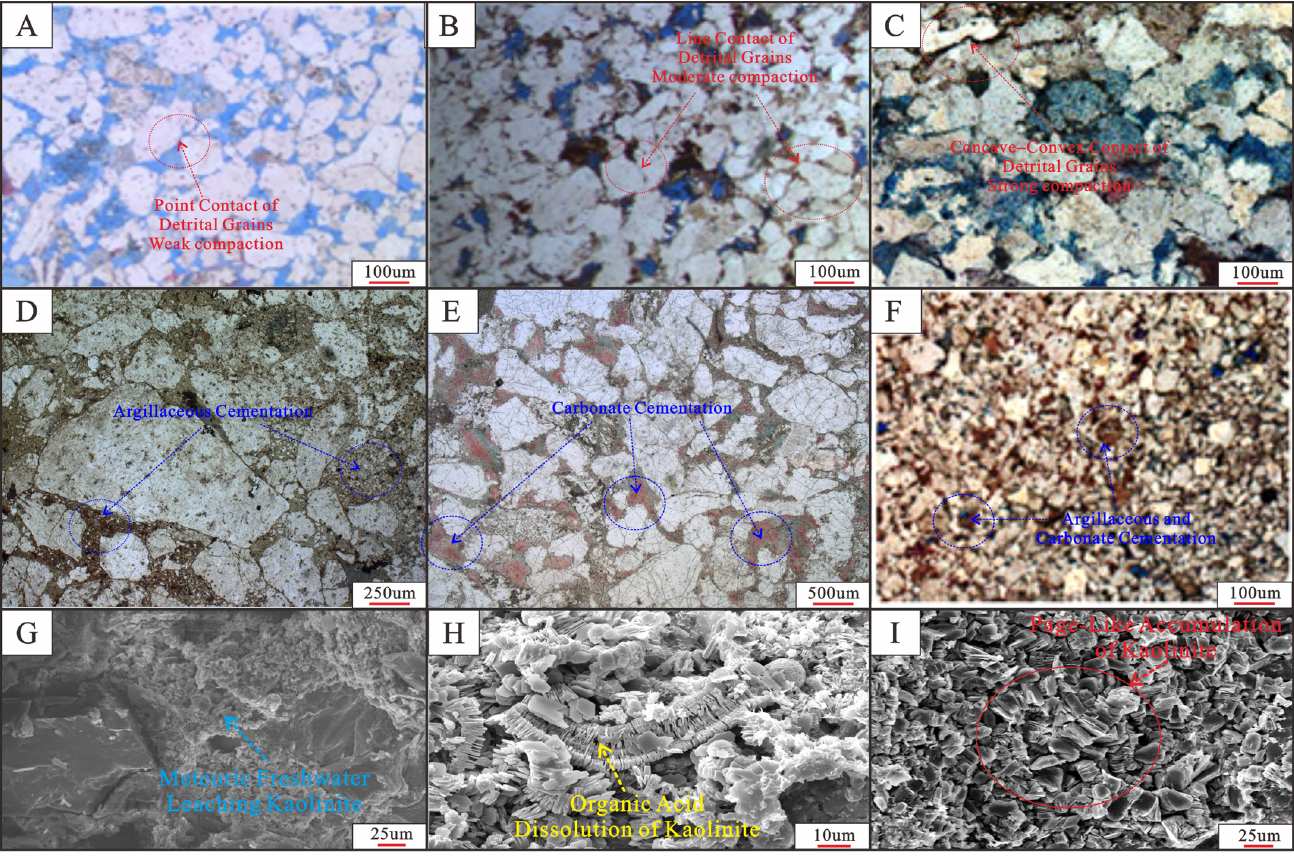
Figure 6. The thin section and scanning electron microscope photographs of the diagenesis of a typical well in the northern steep-slope zone of the Weixinan Sag. ( A ). Well W5, 2053.2 m, the point contact of detrital grains. ( B ). Well C3, 3158.44 m, the line contact of detrital grains. ( C ). Well E3, 3566.74 m, the concave–convex contact of detrital grains. ( D ). Well W3, 1935.9 m, the argillaceous cementation. ( E ). Well C3, 3229.31 m, the carbonate cementation. ( F ). Well E3, 3571.82 m, the argillaceous and carbonate cementation. ( G ). Well W1, 2152.65 m, the early meteoric freshwater leaching kaolinite. ( H ). Well C2, 2677.16 m, the late organic acid dissolution of kaolinite. ( I ). Well E2, 3047.85 m, the page-like accumulation of kaolinite and typical late dissolution.